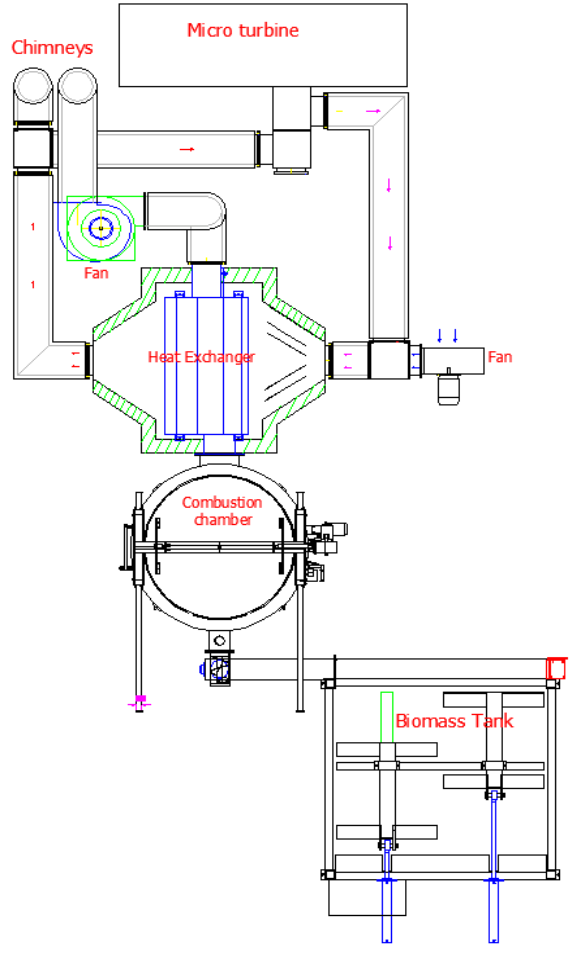
Figure 2. The layout of the investigated plant.